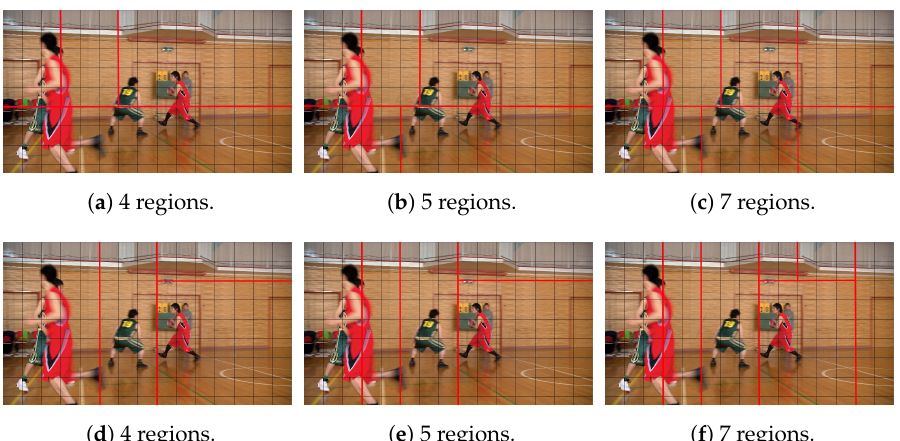
Figure 6. BasketballDrive video sequence: ( a – c ) Serial Region Growing, ( d – f ) Concurrent Region Growing.